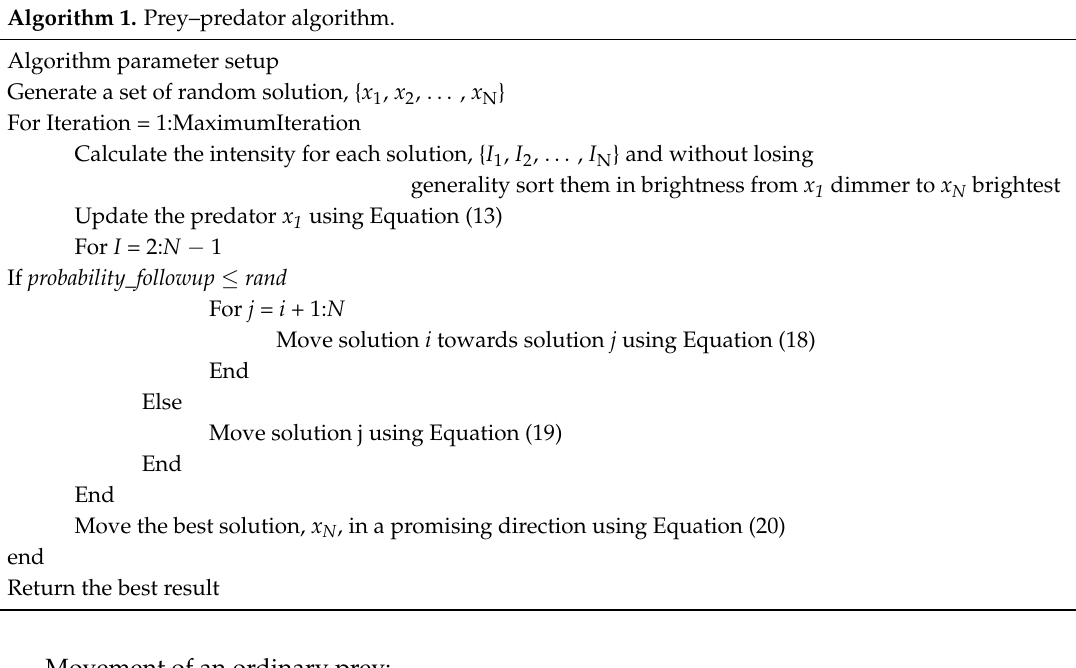
Algorithm 1. Prey–predator algorithm. Algorithm parameter